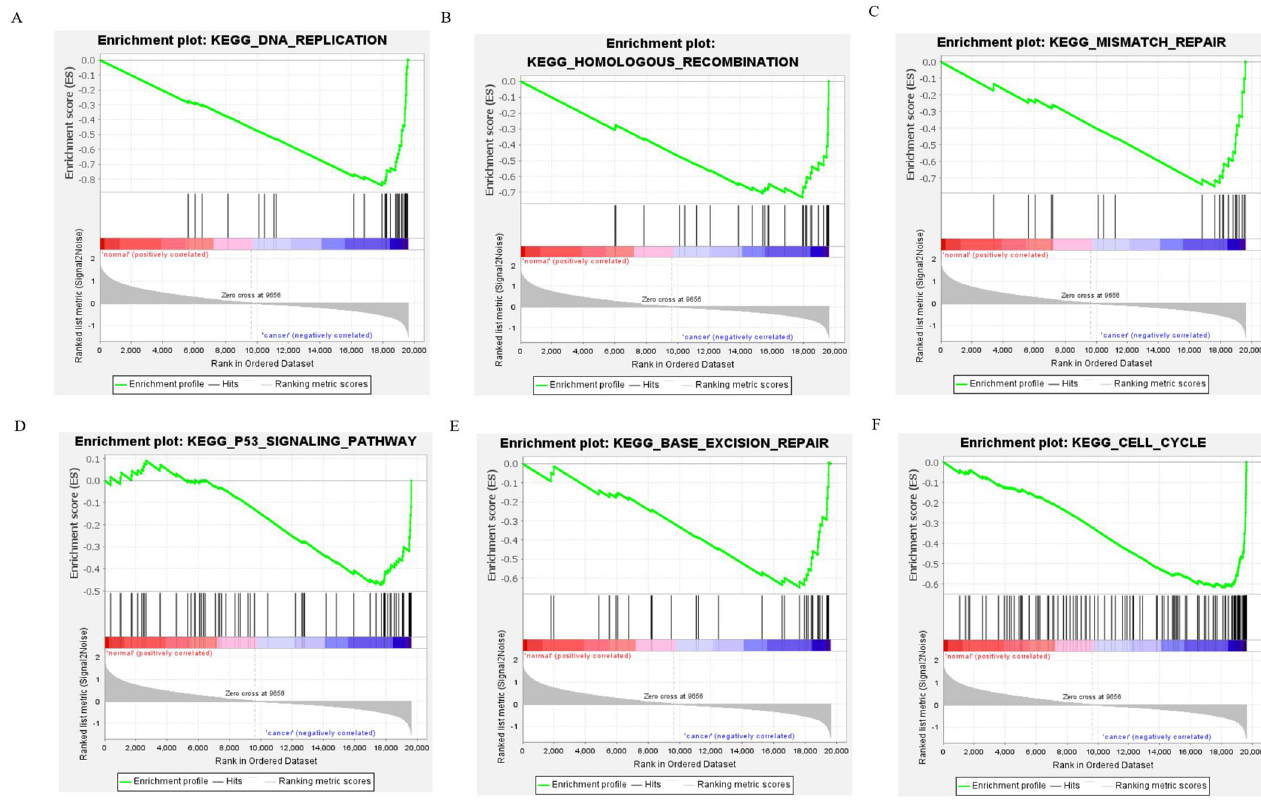
Fig 9. GSEA analysis of the differentially expressed